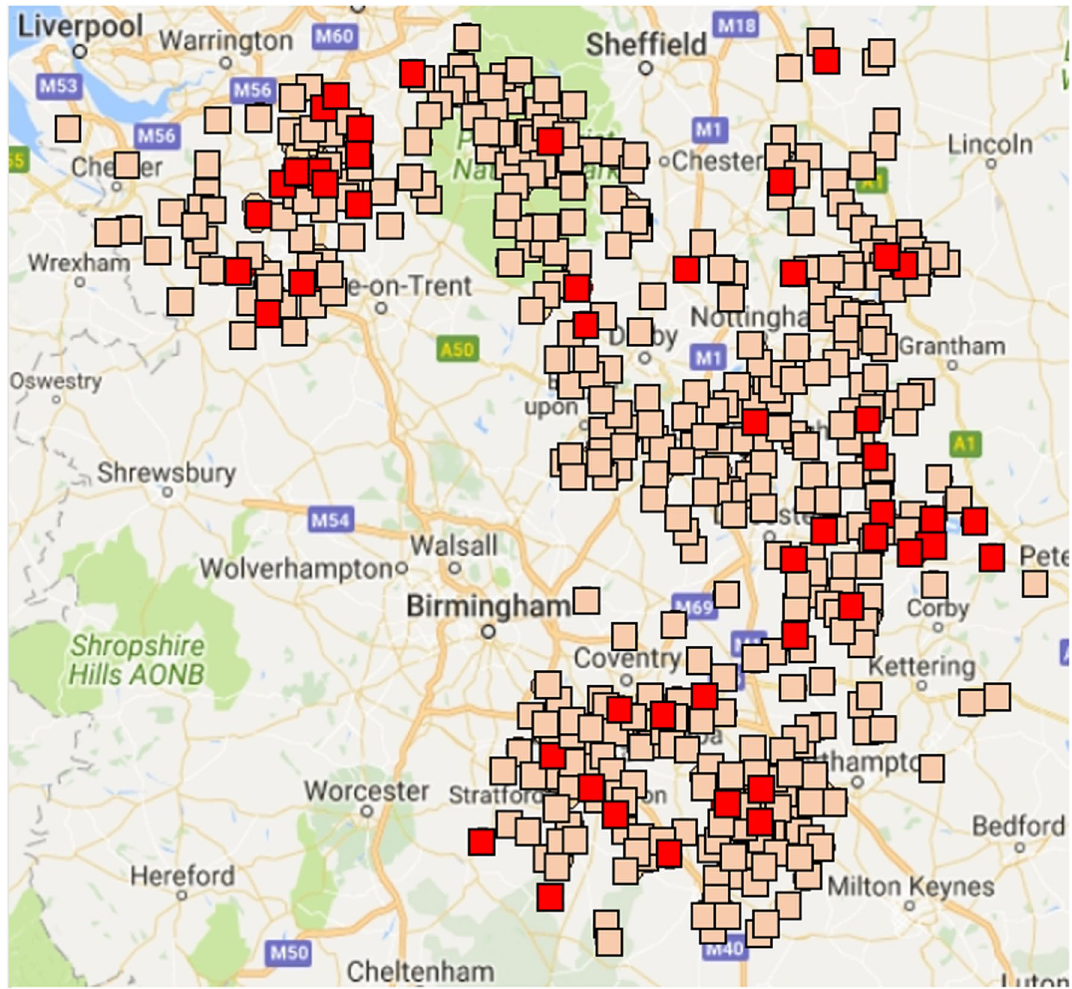
Figure 2. ( A ) the geographic distribution of badger carcasses sampled with those culture positive for confirmed Mycobacterium tuberculosis complex (MTC) in red and those negative in tan. (Original map generated in